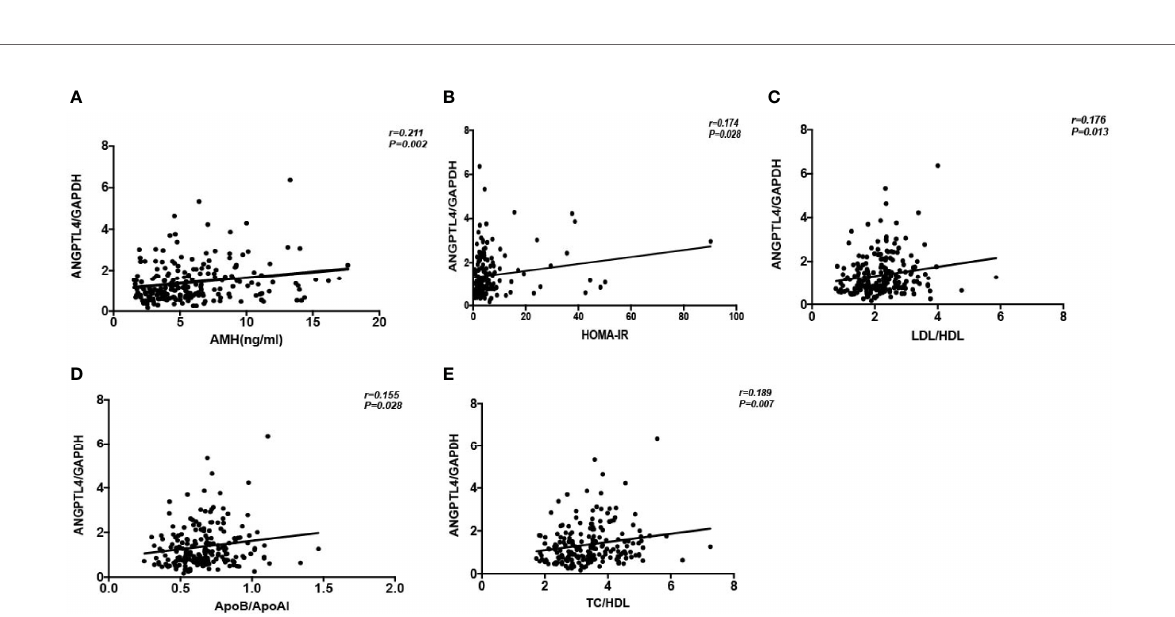
FIGURE 3 | Correlation analysis of ANGPTL4 expression and clinical characteristics. (A) AMH (r = 0.211; P = 0.002). (B) HOMA-IR (r = 0.174; P = 0.028). (C) LDL/ HDL (r = 0.176, P = 0.013). (D) ApoB/ApoAI (r = 0.155, P = 0.028). (E) TC/HDL (r= 0.189, P=